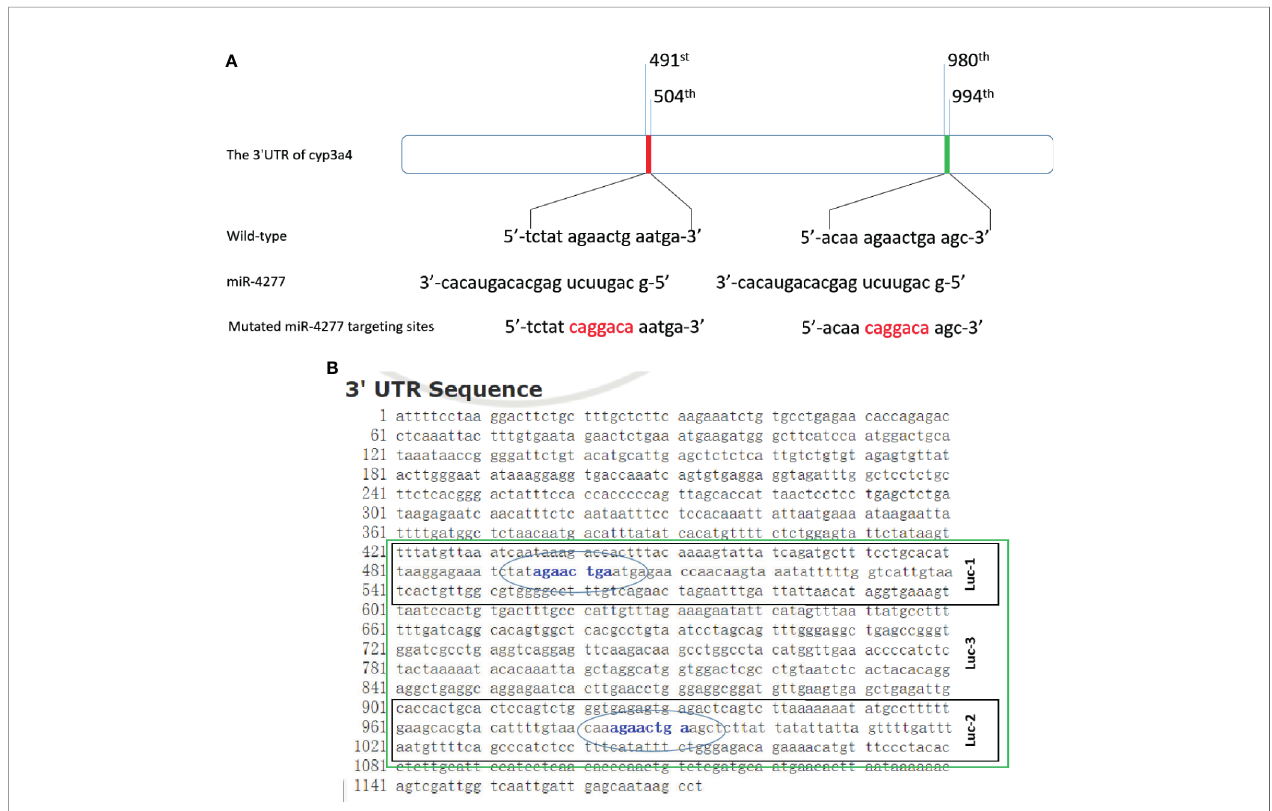
FIGURE 2 | miR-4277 is predicted to target the 3 ’ UTR of cyp3a4 . (A) The sequences of miR-4277 and cyp3a4 are shown as schematic diagrams. (B) The luciferase reporters containing the 3 ’ UTR region of cyp3a4 containing the miR-4277 binding site are shown as a schematic diagram.